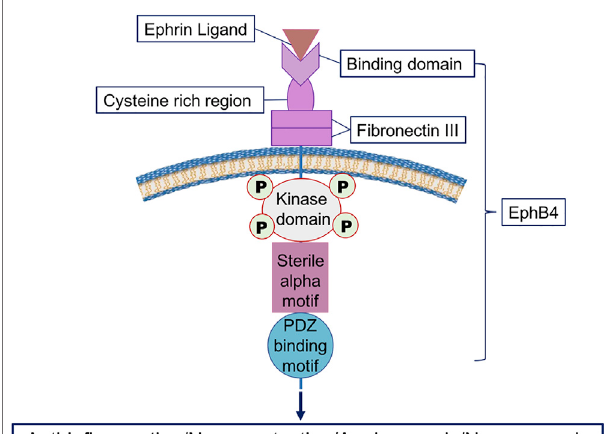
FIGURE 3 | Illustration of the interaction between the ephrin ligand and the receptor EphB4. EphB4 has an extracellular region and an intracellular region.Theextracellularregionincludesanephrin-bindingdomain,acysteine- rich region, and two fi bronectin type III repeats, while the intracellular region contains a tyrosine kinase domain, a sterile alpha motif domain, and a PDZ-binding motif. The ephrin ligand, for example, ephrin4 binds to EphB4 to initiate multiple effects including anti-in fl ammation, neuroprotection, angiogenesis, and neurogenesis during pathophysiological conditions (Salgia et al., 2018; Chen Y. et al., 2019; Elgebaly,